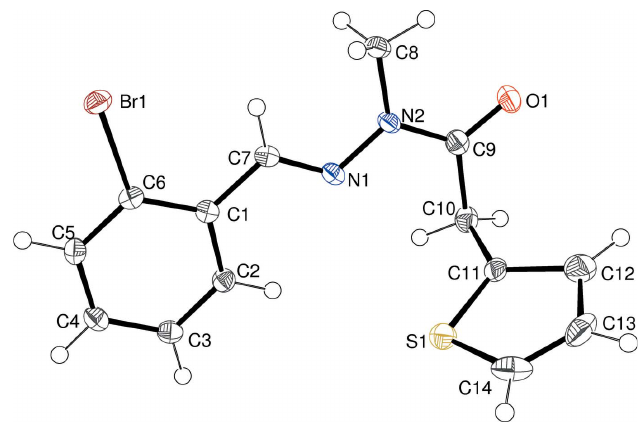
Figure 2 The molecular structure of (II), showing 50% probability displacement ellipsoids. Only the major orientation of the thiophene ring is shown.